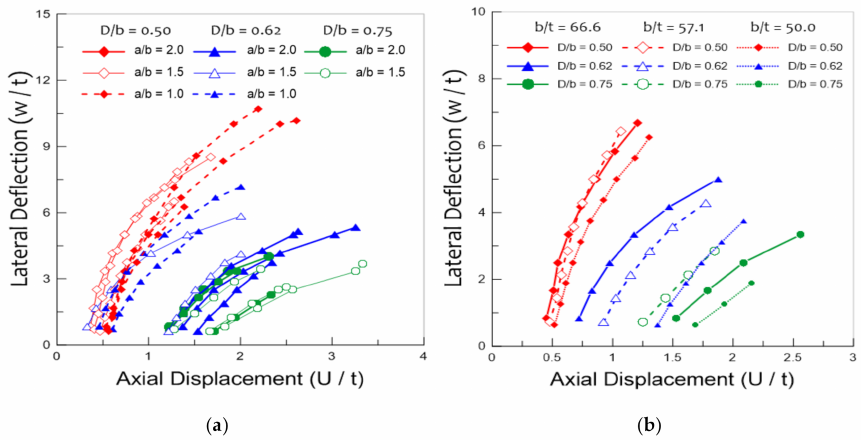
Figure 11. Relationship between lateral deflection and axial displacement ( a ) dependent on aspect ratio and ( b ) opening